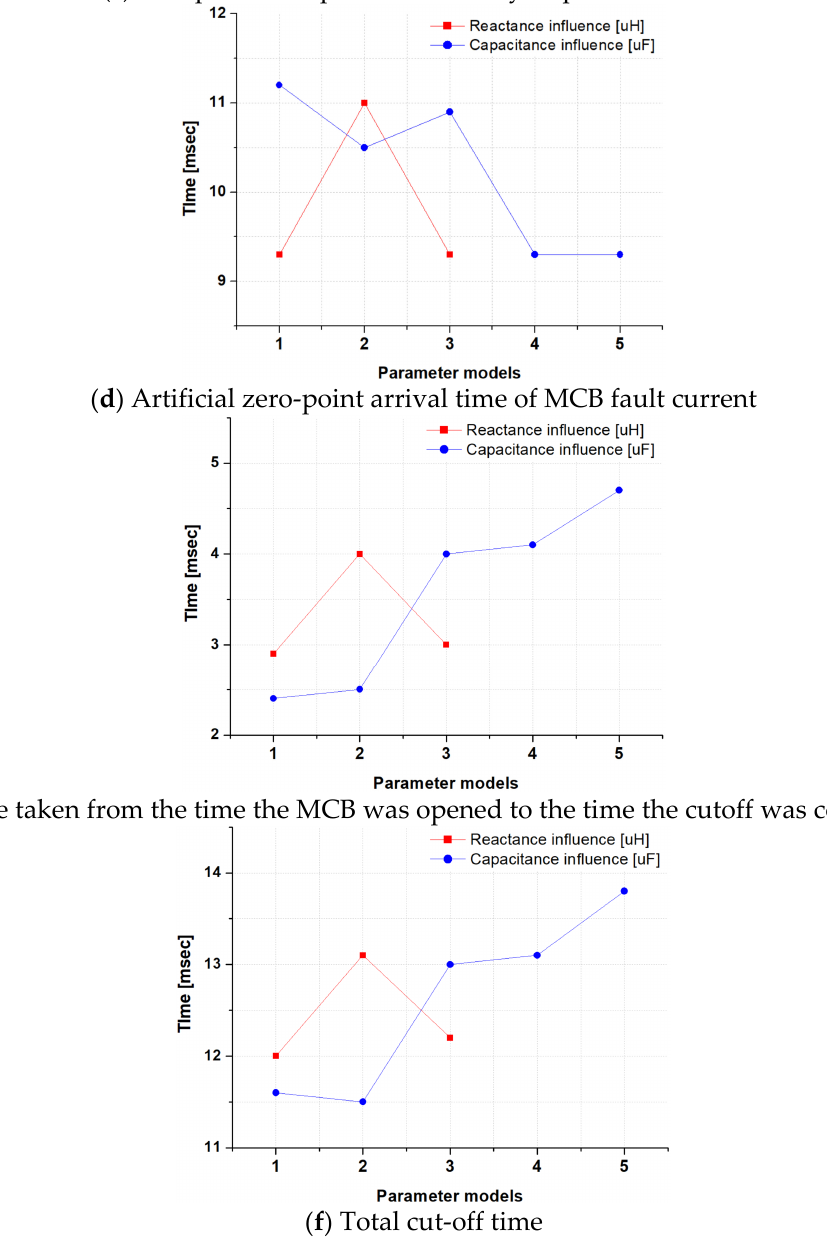
Figure 7. Comparison of operating characteristics for each standard.